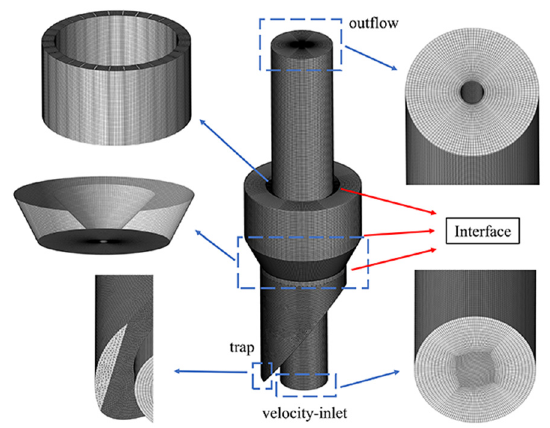
Figure 2. CFD grid and boundary conditions of the simulated classifier.